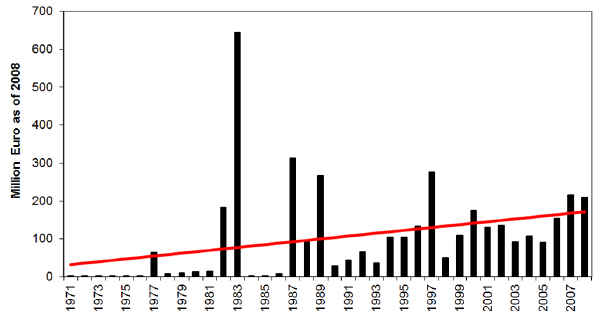
Fig. 1. Spain’s flood insured losses 1971–2008 adjusted for inflation to 2008 Euros (linear trend in